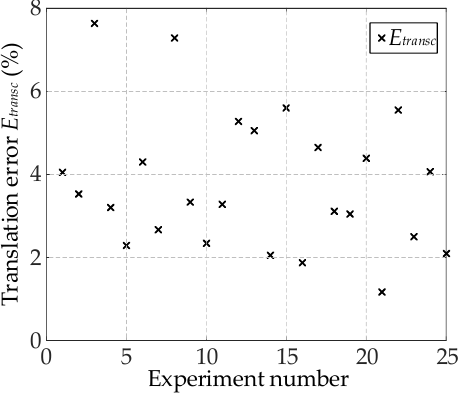
Figure 21. Modified translation error E transc from various experiments.